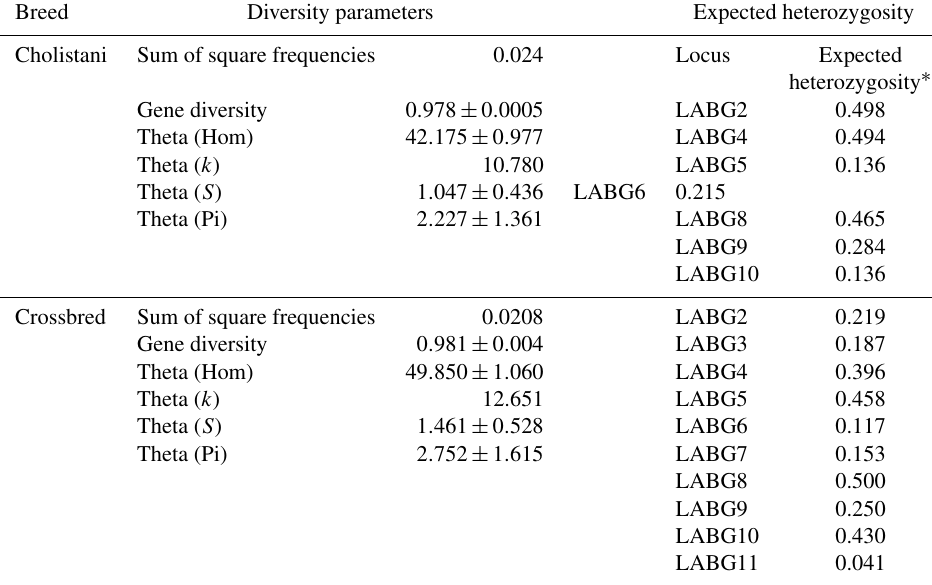
Table 4. Within-breed diversity of haplotypes and expected heterozygosity of Cholistani and crossbred cattle.